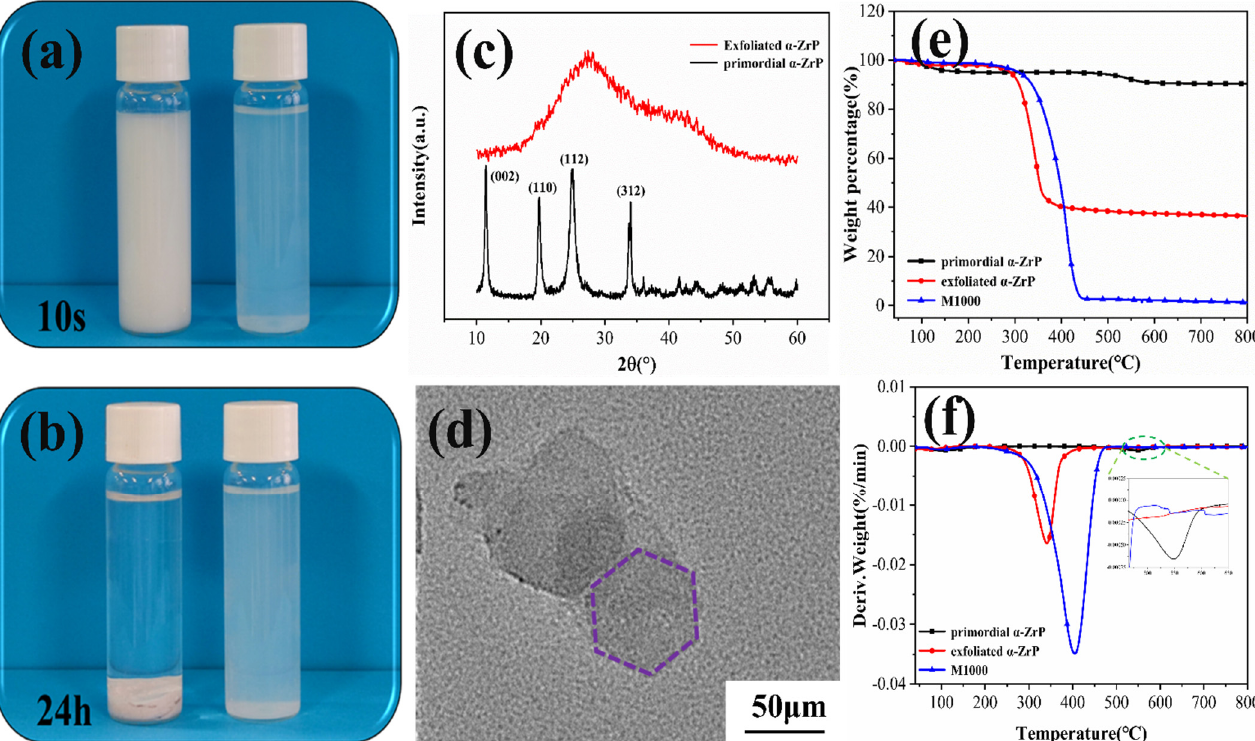
Figure 2. Analyses of exfoliated α -ZrP and primordial α -ZrP: ( a , b ) photographs of the suspensions; ( c ) Raman spectra; ( d ) TEM image of exfoliated α -ZrP; ( e ) TGA curves; and ( f ) DTG curves.